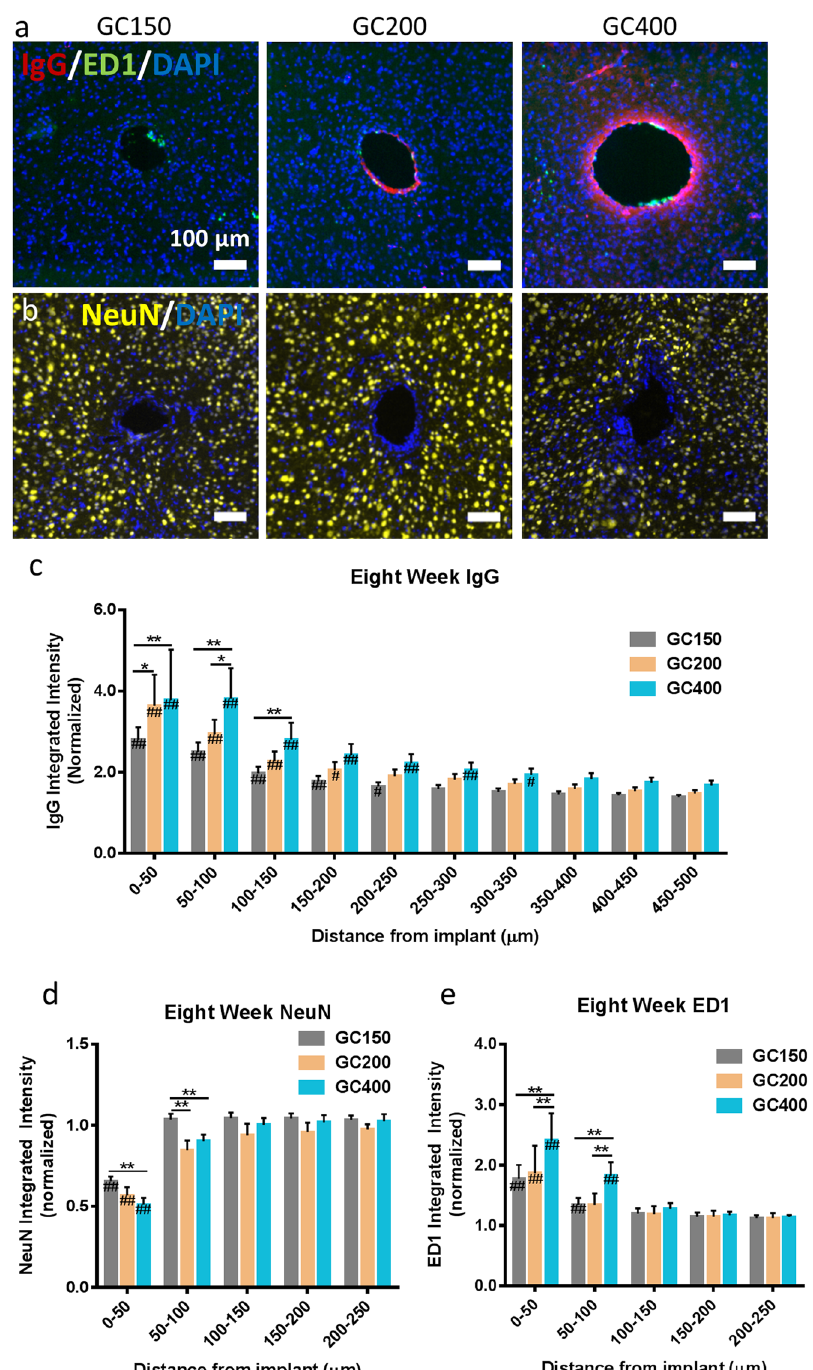
Figure 4. Implant Diameter Comparison. Increasing implant diameter increases scarring at 8 weeks post implantation when implant modulus is held constant. Glass capillaries with diameters ranging from 150 μ m to 400 μ m were implanted into the rodent brain and analyzed at 1, 4, and 8 weeks post implantation. ( a ) The GFAP activity as a function of distance from the implant at 1 week. A slight decrease in the GFAP reactivity was observed directly around the implants for the larger capillaries. ( b ) GFAP reactivity at four weeks post implantation. GFAP reactivity was increased around the implant for 400 μ m implants at 4 weeks post implantation. The GC400 group had increased scarring compared to GC200 and GC150 groups in the 100 μ m surrounding the implant. ( c ) Representative IF images (scale bar (100 μ m) of the GFAP reactivity at 8 weeks post implantation. ( d ) GFAP reactivity at 8 weeks post implantation. Increased diameter (200 μ m and 400 μ m) implants were found to produce increased scarring at eight weeks post implantation. ** p < 0.01, * p < 0.05 indicates a statistically significant difference between cohorts at a given distance from the implant interface. ## p < 0.01, # p < 0.05 indicates a statistically significant difference compared to background. Cohort sizes (1 wk, 4 wk, 8 wk). GC150 = (11, 11, 18), GC200 = (6, 5, 7), GC400 = (6, 5, 10). Each n corresponds to an individual animal (biological replicate). A minimum of four sections were analyzed per